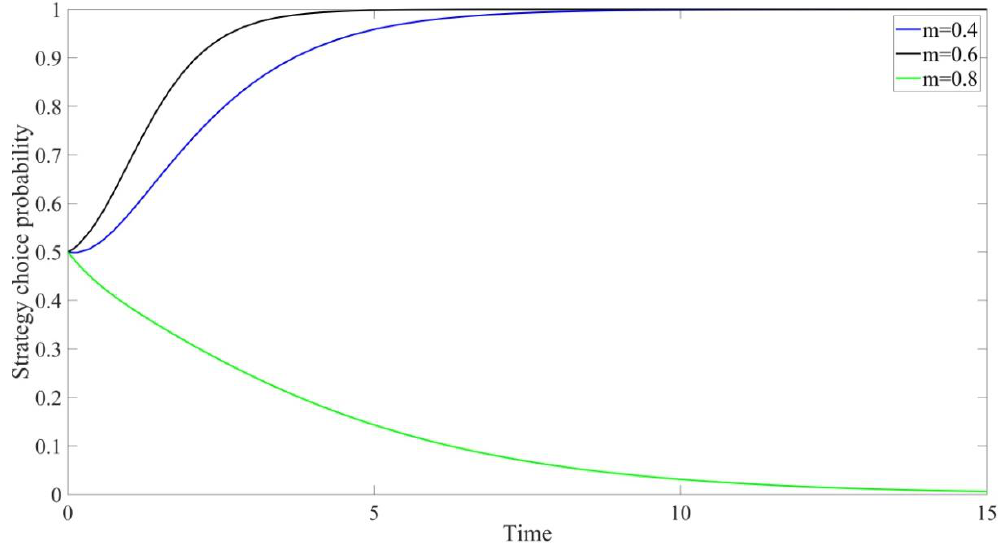
Figure 15. Simulation of different intensities of government supervision.